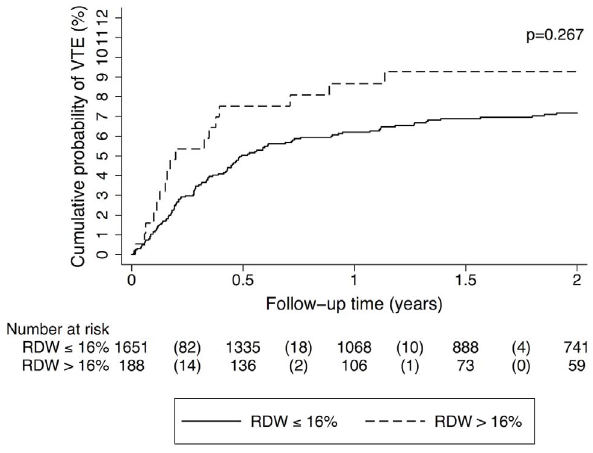
Figure 1. Cumulative incidence of venous thromboembolism (VTE), accounting for competing risk (death of any cause) in the total study cohort, grouped into patients with red cell distribution width (RDW) . 16% and below ( # 16%), respective- ly. In competing risk analysis (accounting for death of any cause), the probability of VTE was not significantly different between patients with high RDW ( . 16%) and patients with non-elevated RDW (Gray’s test p=0.267). Numbers in parentheses indicate numbers of VTE events in the respective group and time period.